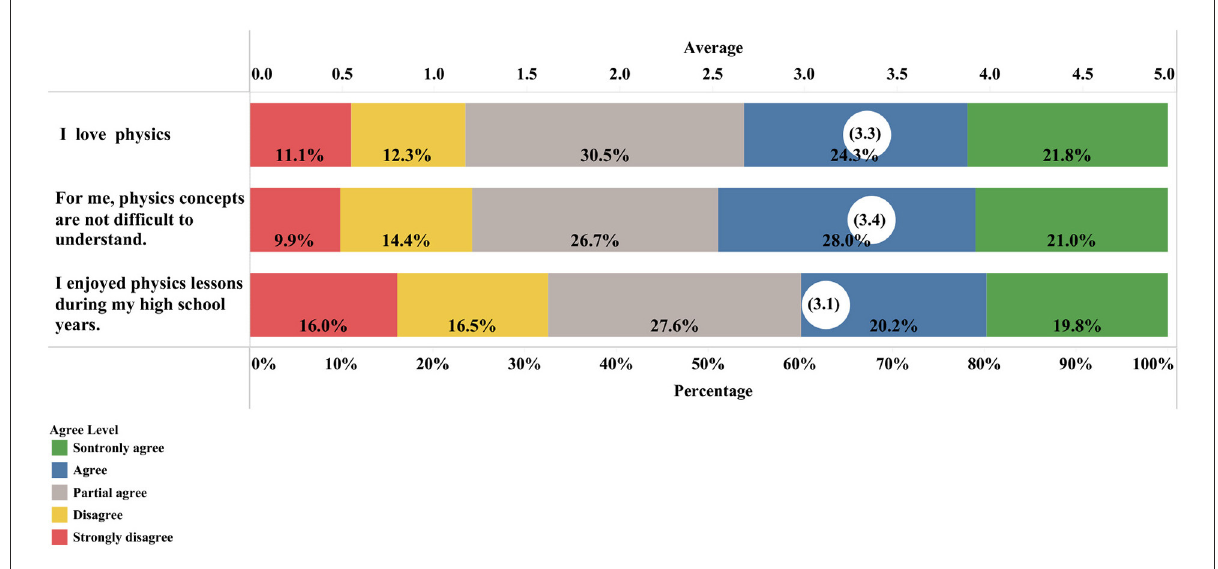
FIGURE1 Distribution based on item related to attitude and agrees with